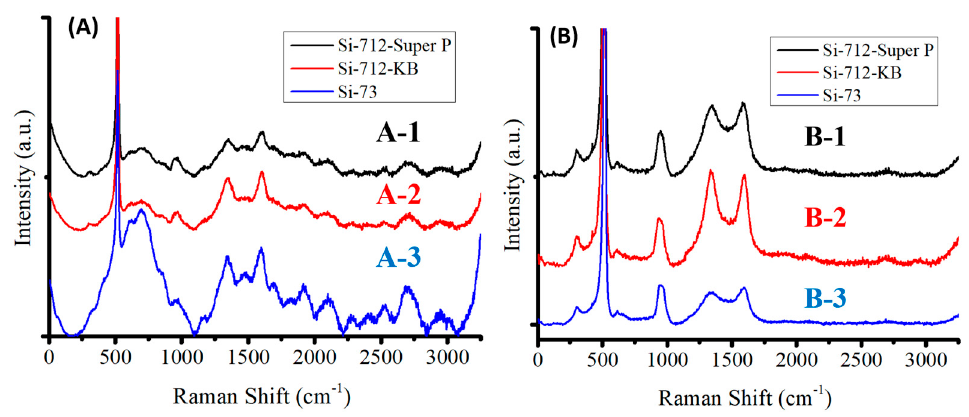
Figure 3. Raman spectra of ( A ) anodes made of (A-1) silicon:Super P:CMC/SBR = 70%:10%:20%, (A-2) silicon:KB:CMC/SBR = 70%:10%:20%, and (A-3) silicon:CMC/SBR = 70%:30%. ( B ) Anodes after pyrolysis and made of (B-1) silicon:Super P:CMC/SBR = 70%:10%:20%, (B-2) silicon:KB:CMC/SBR = 70%:10%:20%, and (B-3) silicon:CMC/SBR = 70%:30%. Raman excitation was performed by a 532 nm laser.